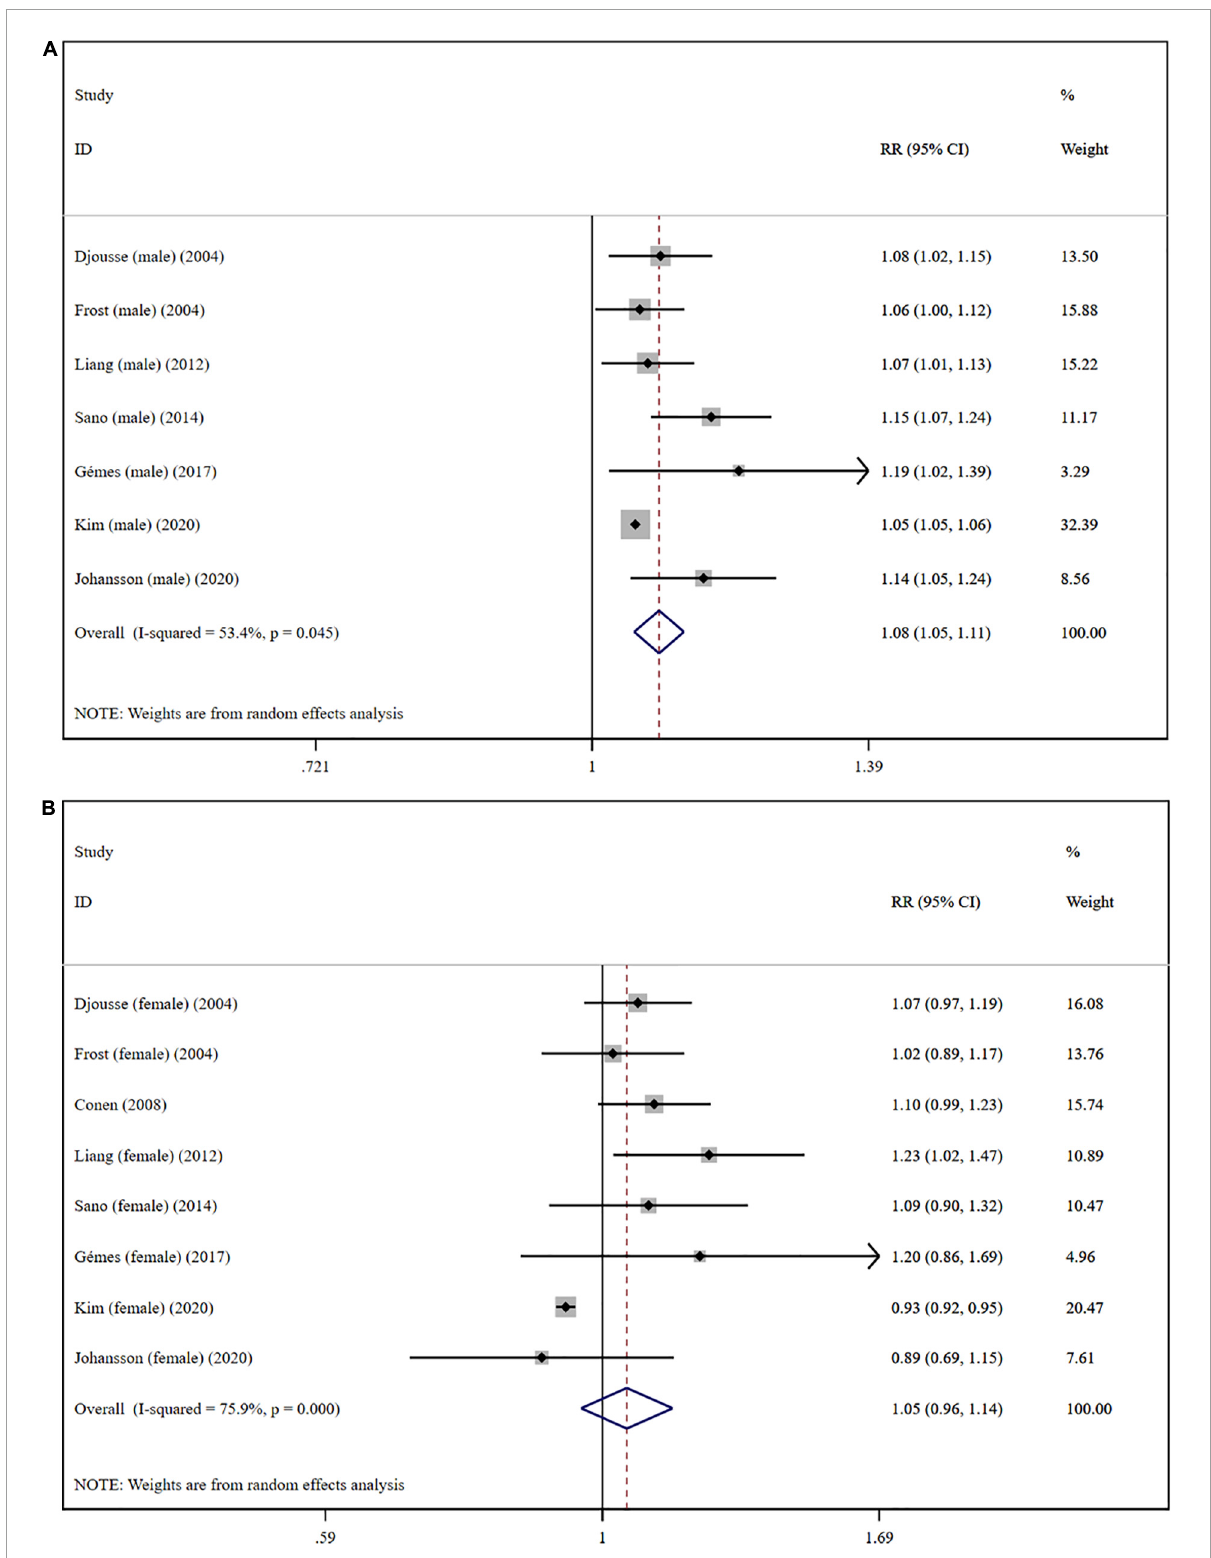
FIGURE5 Subgroup analysis of relative risks of atrial fibrillation per 1 drink/day increment in alcohol consumption in different gender. (A) Men; (B) women.